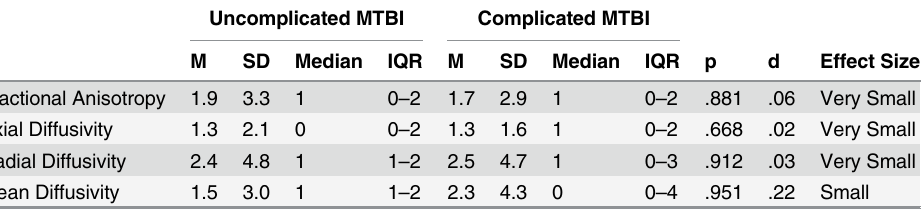
Table 7. Descriptive statistics, group comparisons, and effect sizes for the 48 ROI DTI